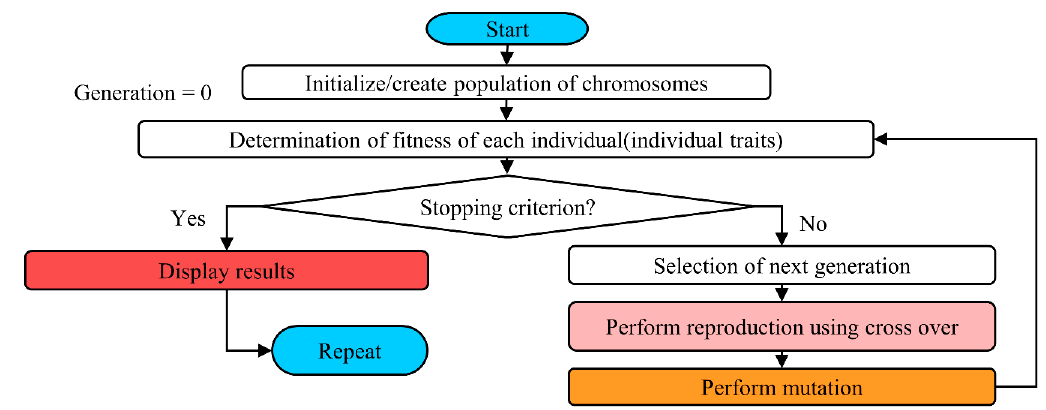
Figure 6. Basic flowchart of a genetic algorithm.